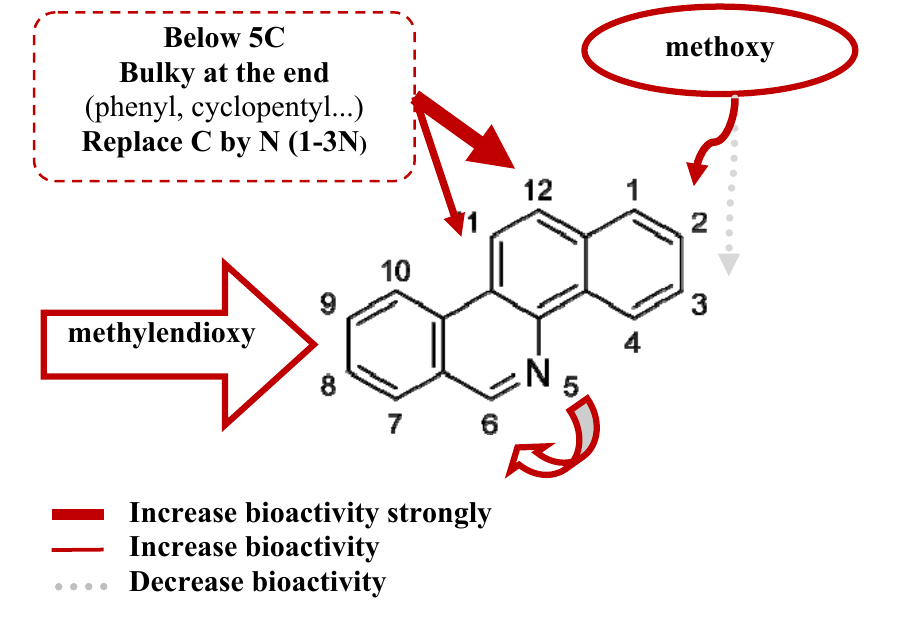
Figure 4. The summary for BCPs structures—antitumor activity relationship.